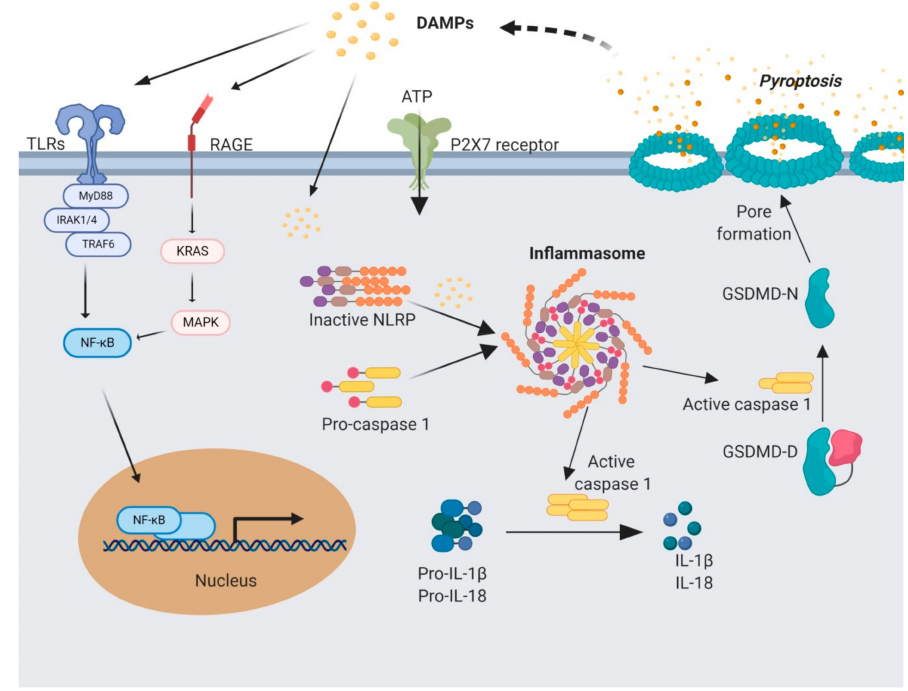
Figure 2. Mediators involved in sterile inflammation signaling and pyroptosis. Sterile inflammation is triggered by a first signal triggered by DAMPs that can act on receptors such as toll-like receptors (TLRs), RAGE and PRX7. Activating signaling by TLRs initiates a cascade that translocates NF- κ B in the nucleus and stimulates pro-IL-1 β and pro-IL-18 expression. A second signal stimulates inflammasome assembly from NOD-like Receptors (NLRs), caspase activation and recruitment domain (CARD) and pro-caspase 1 that is cleaved and activated within this complex. Activated caspase-1 further activates IL-1 β and IL-18 and also releases the N -terminal of gasdermin, responsible for pore formation and initiation of pyroptosis. IL-1 β , IL-18, along with DAMPs are released from the cell by means of the pores and initiates a self-perpetuating loop of sterile inflammation. Figure created with